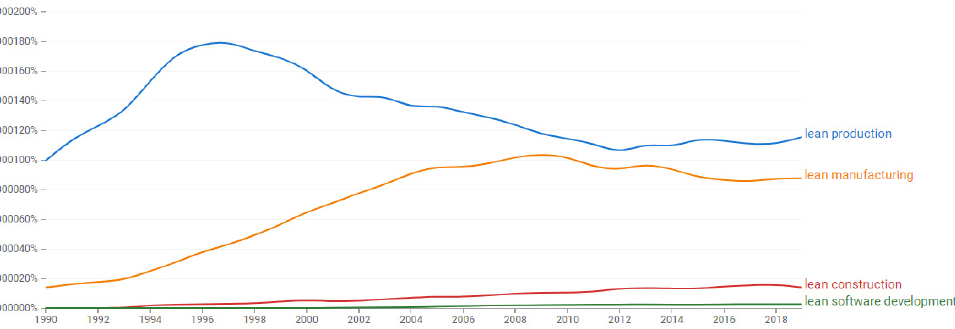
Figure 5. Evolution of the terms “lean production”, “lean manufacturing”, “lean construction” and “lean software development” (Data source: Google Books Ngram Viewer, available at http://books.google.com/ngrams, retrieved 25 August 2022).